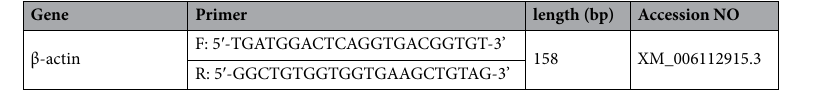
Table 1. Real-time PCR primer sequences. Nrf2, NF-E2-related factor 2; Keap1, Kelch-like-ECH-associated protein 1; SOD1 (CuZnSOD), copper, zinc superoxide dismutase; SOD2 (MnSOD), manganese superoxide